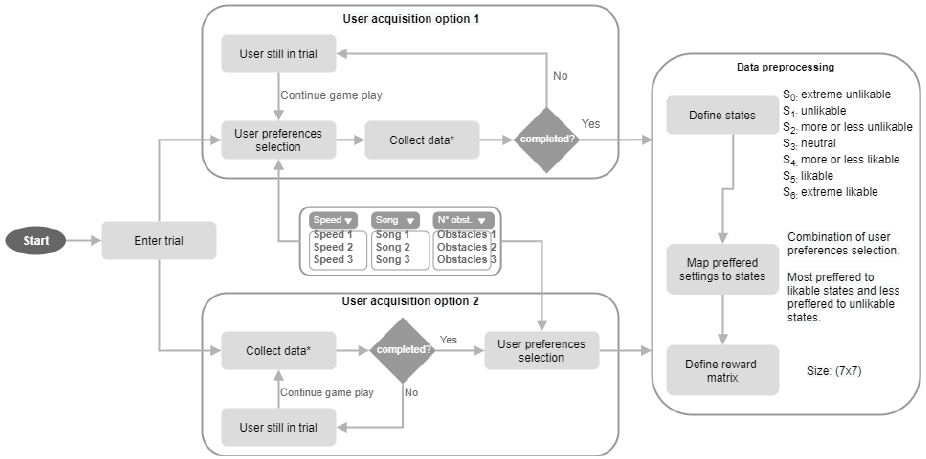
Figure 13. Related elements in the user profile acquisition